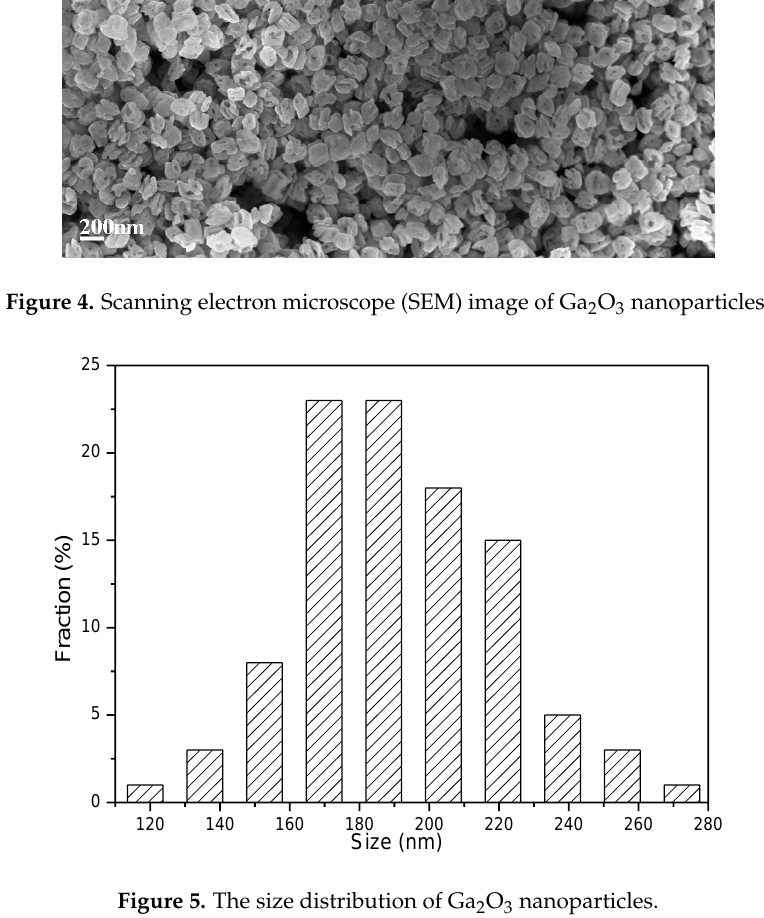
Figure 5. The size distribution of Ga 2 O 3 nanoparticles.